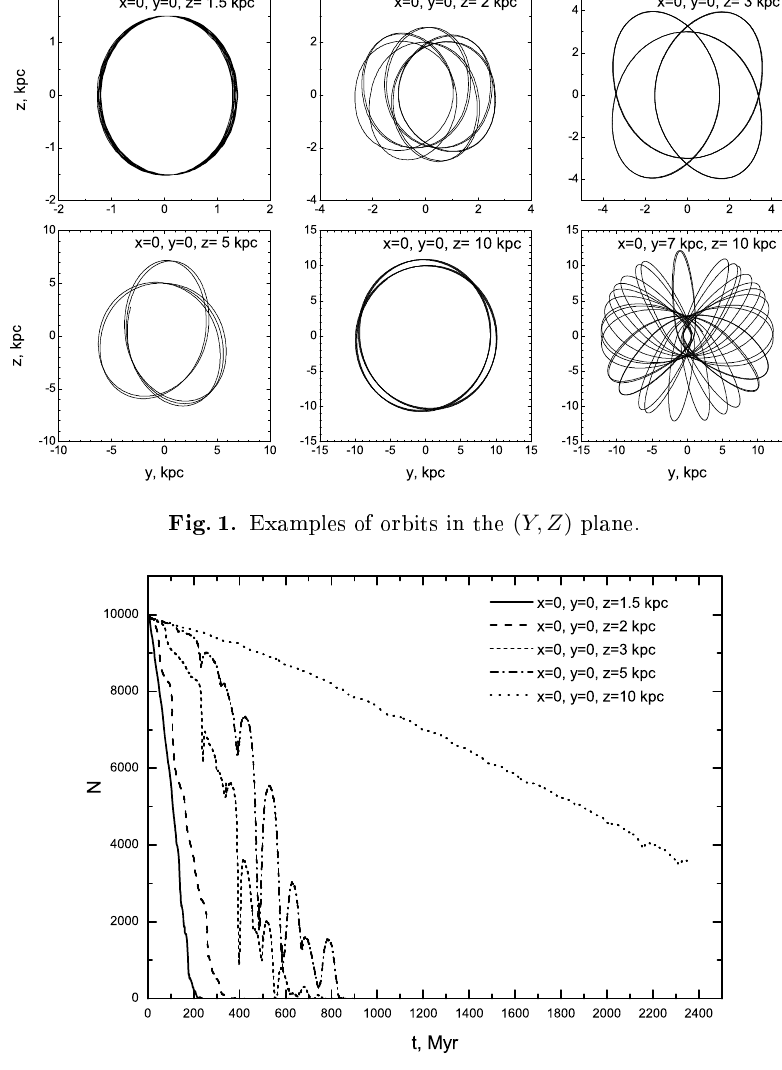
Fig. 2. The number of gravitationally bound stars vs. time for the orbits of Fig.